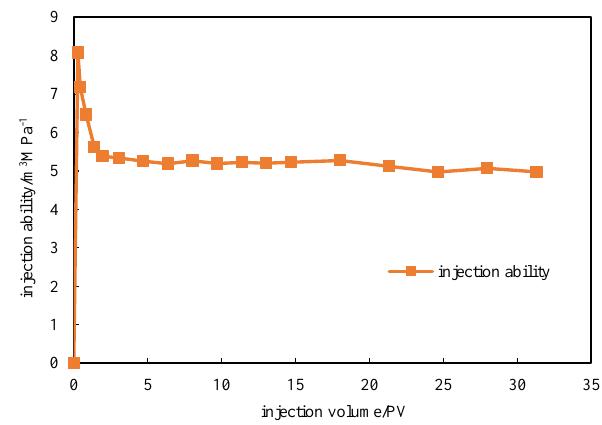
Figure 5. Injection ability and injection multiples relationship diagrams.